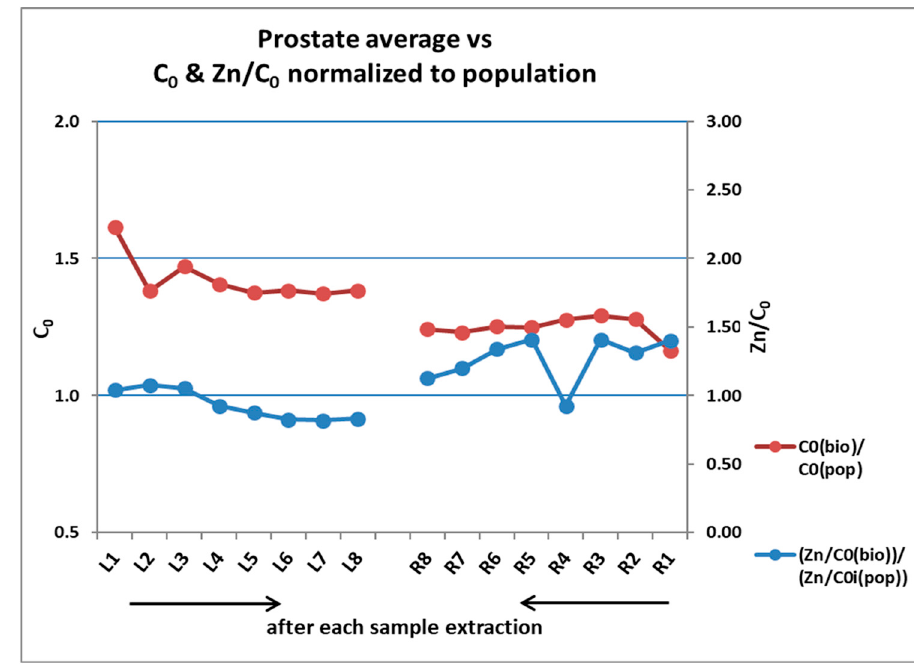
Figure 7. Convergence towards